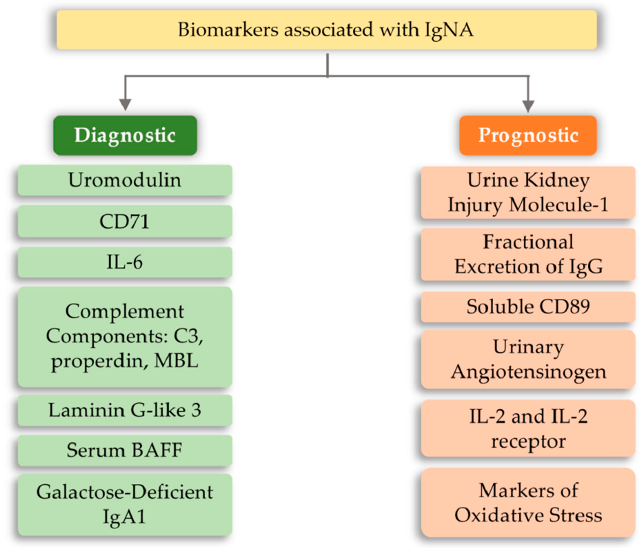
Figure 6. Biomarkers in IgA (immunoglobulin A) nephropathy.